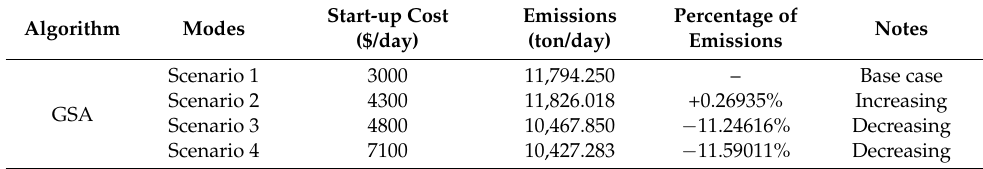
Table 8. Results summary for GSA (including emission cost without considering losses of the system)